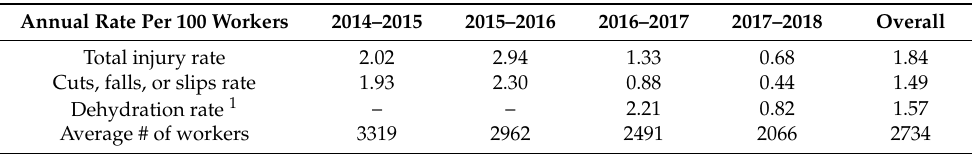
Table 2. Estimated annual rate of recorded injury and dehydration per 100 sugarcane harvesters in Southwestern Guatemala, 2014–2018.